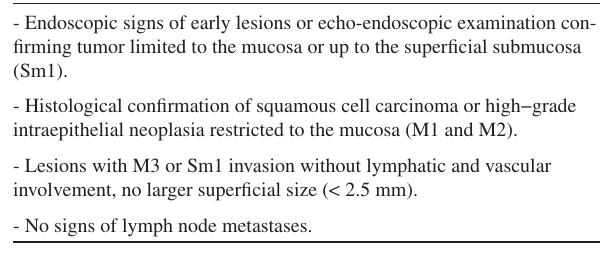
Table 2 - Indication criteria adopted for esophageal cancer endoscopic submucosal